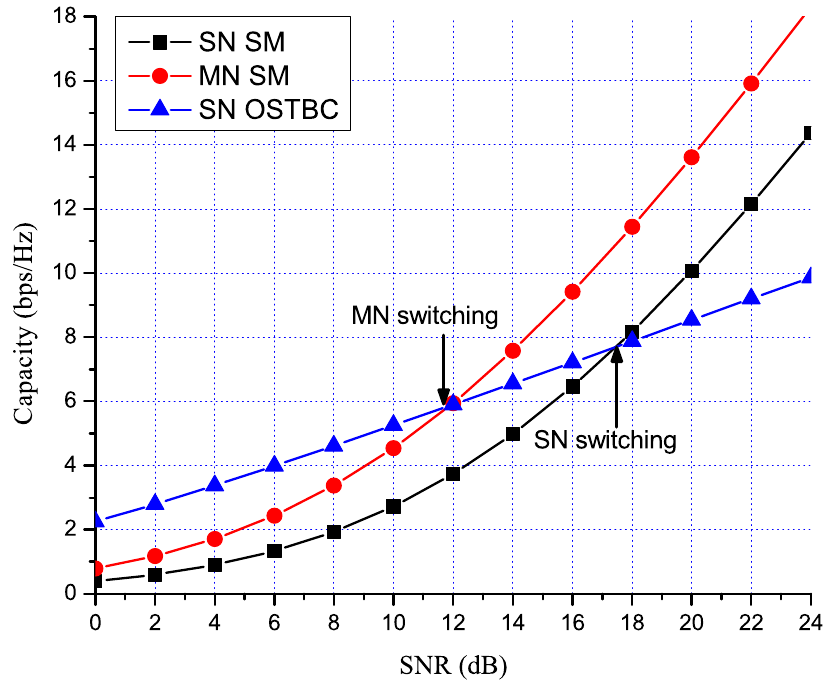
Figure 9. MIMO 4 × 4 capacity with high spatial correlation ( η = 0 . 8 , µ = 0 . 9 ).